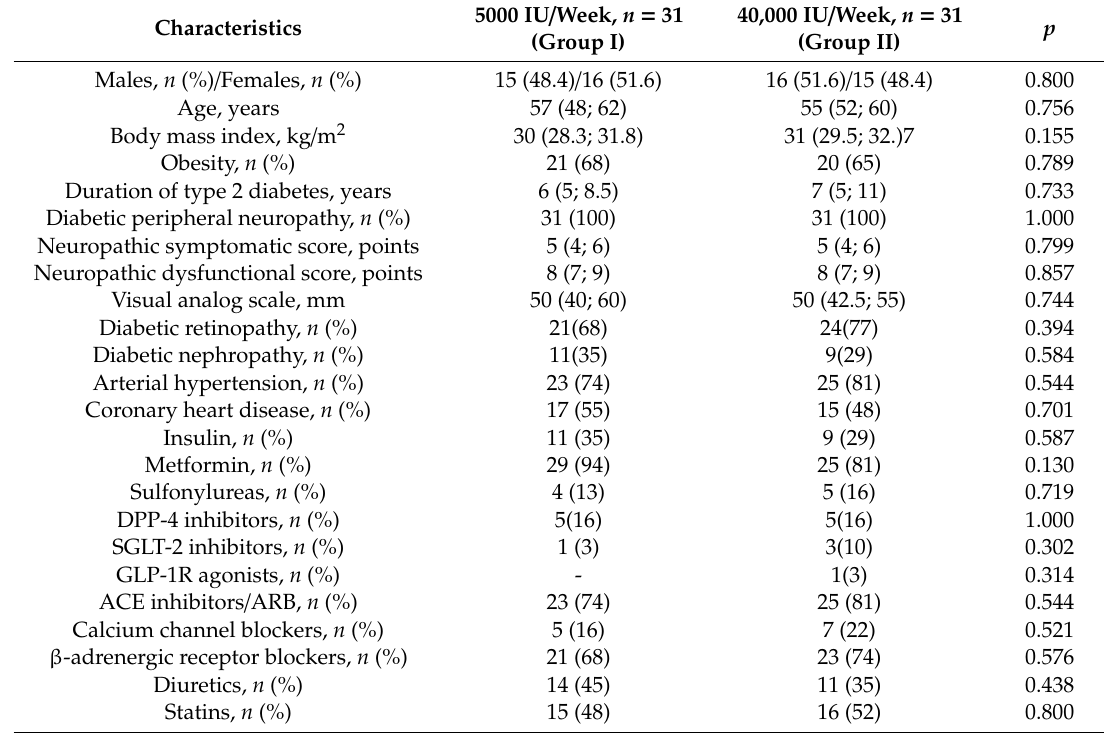
Table 1. Baseline clinical characteristics of type 2 diabetic patients according to randomization.